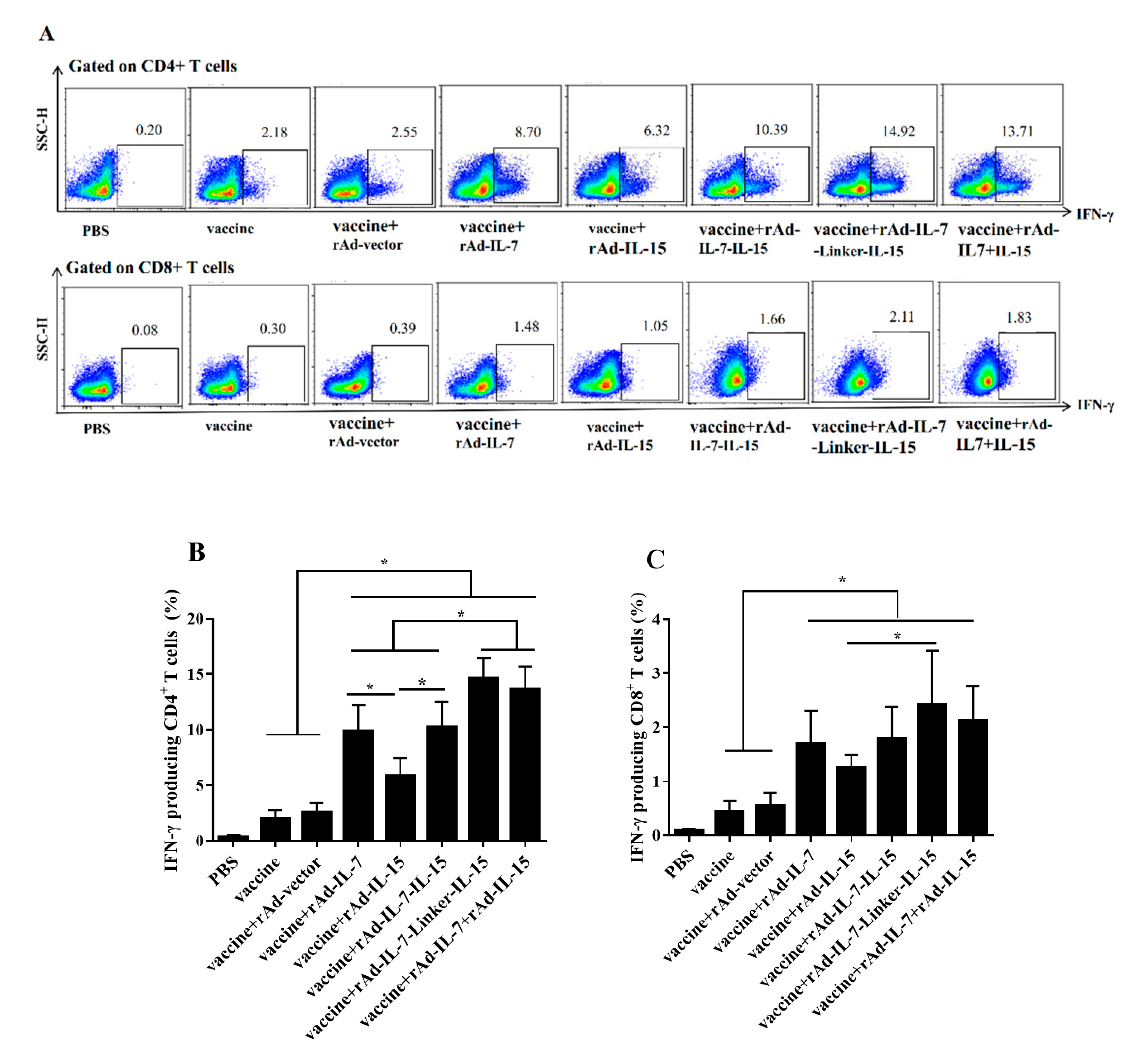
Figure 2. IFN- γ secretion following twice stimulation with antigens in spleens. At 20 weeks after the last immunization, mice were injected with BCG (1 × 10 6 CFU) by i.p for 9 days. Then, lymphocytes of spleens were isolated and stimulated with a cocktail of antigens ESAT-6, Ag85B, Rv2626c and HspX (2 µ g / mL) in vitro. Secretion of IFN- γ was determined by flow cytometry. ( A ) The representative results of every group; ( B ) CD4 + T cells secreting IFN- γ ; ( C ) CD8 + T cells secreting IFN- γ . Data collected were presented as means ± SD from 5 mice per group. * p < 0.05.